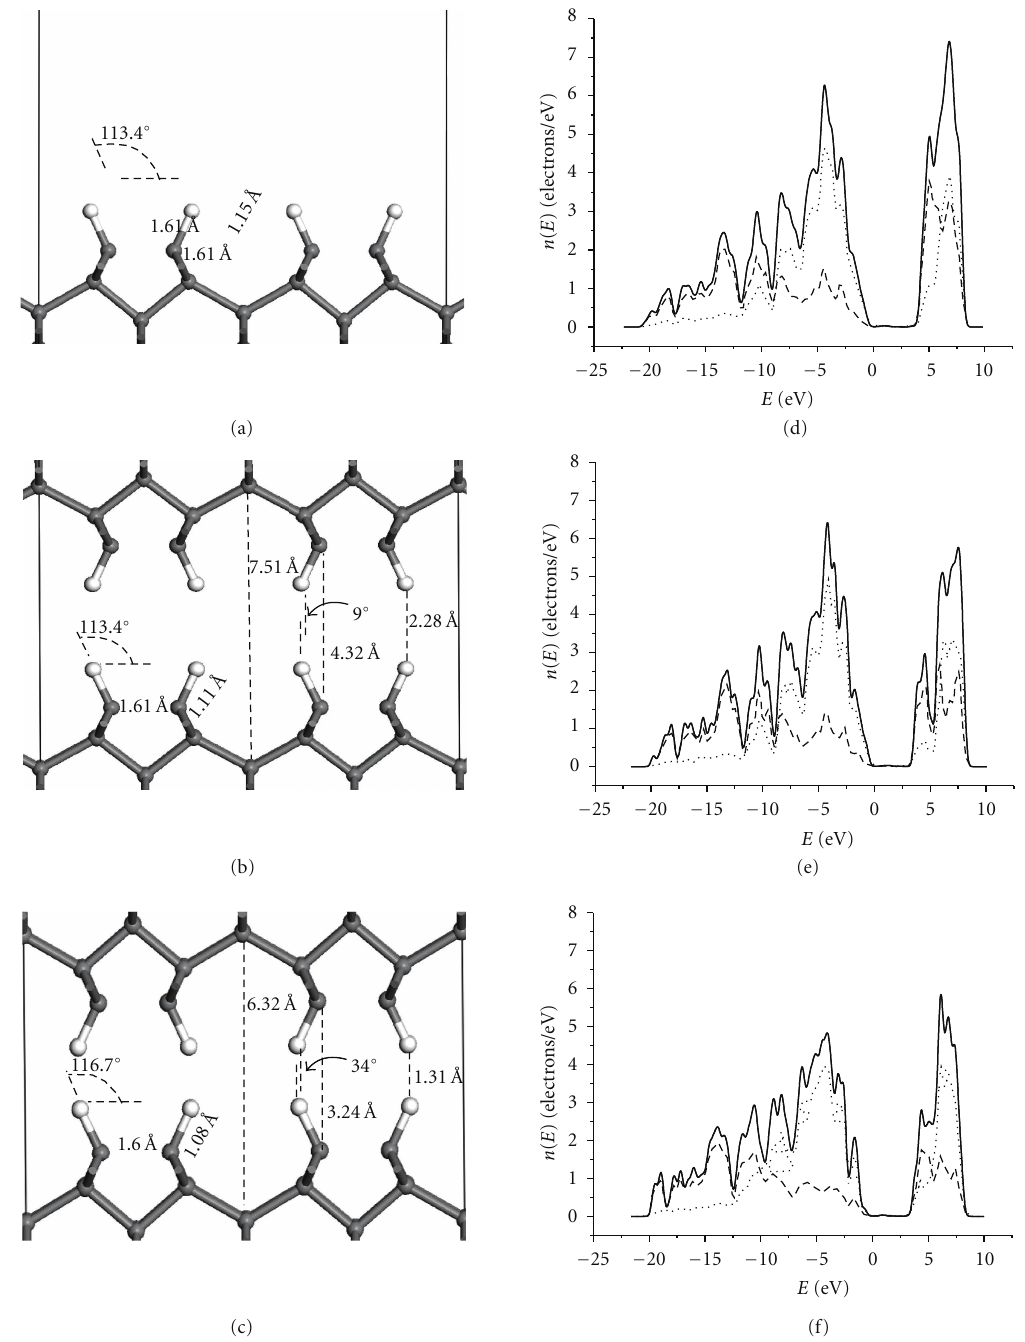
Figure 1: (a) Surface dimer geometry of the fully relaxed C(100)2x1-H; (b) spacing and geometry of the cohesive state between C(100)2x1-H surfaces at 4.32 ˚A dimer carbon-to-opposite surface dimer carbon spacing; (c) geometry of slab-to-slab repulsive state at a 3.24 ˚A dimer-to- dimer spacing; (d) DOS of the dimer and first carbon atom layer shown in part (a), solid line is total DOS, dashed line the s-states partial DOS and the dotted line the p-states partial DOS, VBM = 0eV; (e) similar DOS of the cohesive state shown in part (b); (f) similar DOS of (c) the repulsive interaction between surfaces. Gray spheres represent carbon atoms and white are hydrogen atoms, in all figures.